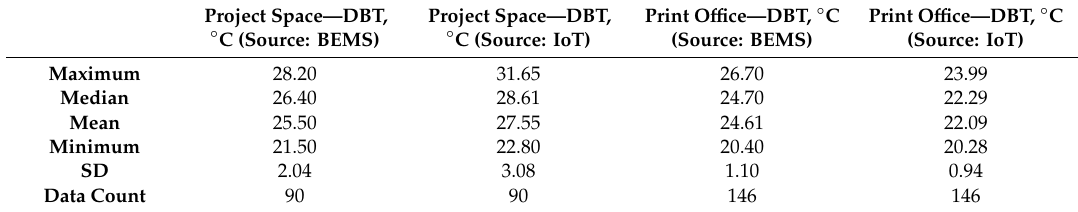
Table 1. Descriptive Statistics of Recorded Data from IoT and BEMS Sensors in Fabrication